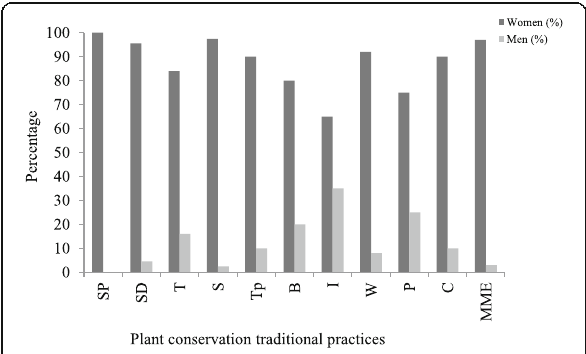
Fig. 4 Performing resource conservation practices by Adi women and me. Abbreviations: SP Seed preservation, SD Species domestication, T Tilling, S Sowing, Tp Transplanting, B Burning, I Irrigating, W Weeding,